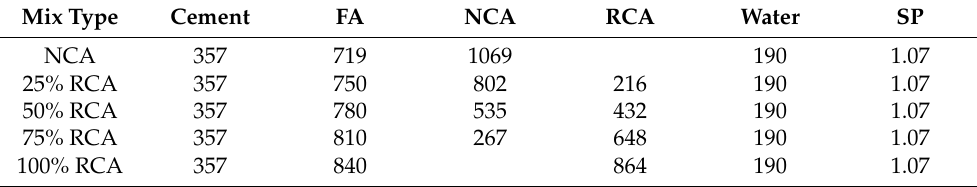
Table 3. Concrete mixture proportions (in kg/m 3